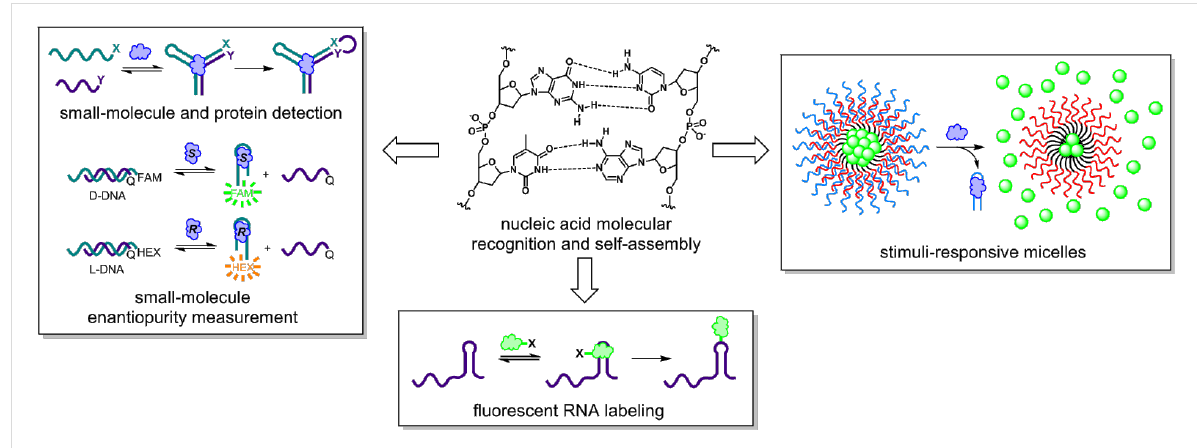
Figure 1: The common thread that is woven throughout our research program is the utilization of nucleic acid molecular recognition and self- assembly to generate functional architectures for biosensing and bioimaging. Adapted with permission from [3]. Copyright (2014) American Chemical Society. Adapted with permission from [4]. Copyright (2015) American Chemical